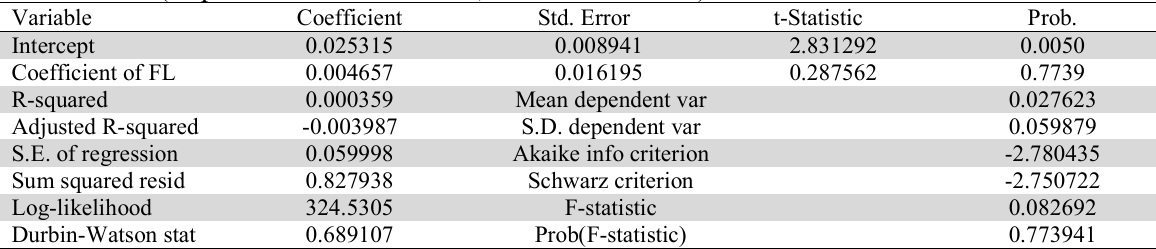
ROCE model (Dependent variable: ROCE, Observations: 357) Variable